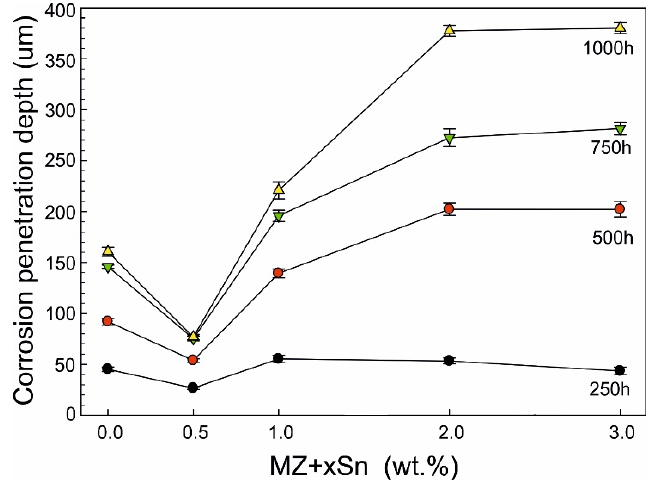
Figure 5. Depth of IG corrosion—as-cast samples.